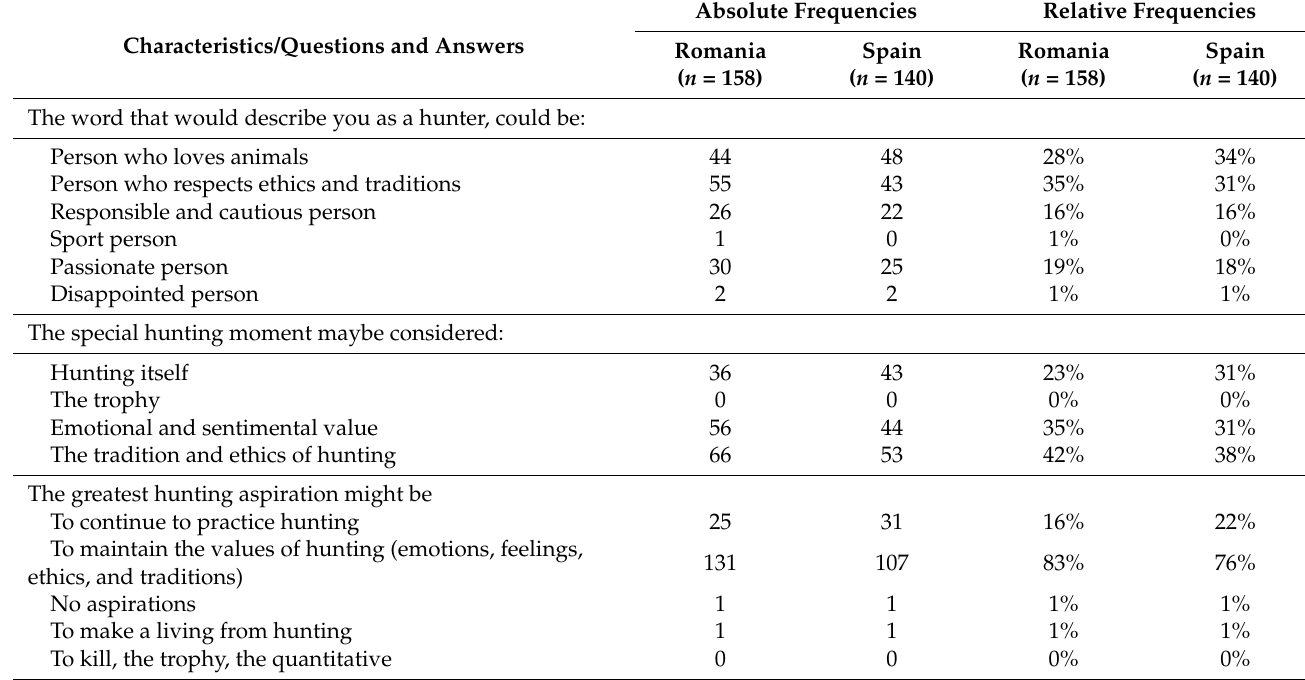
Table 3. The distribution and structure of answers for other hunting data.